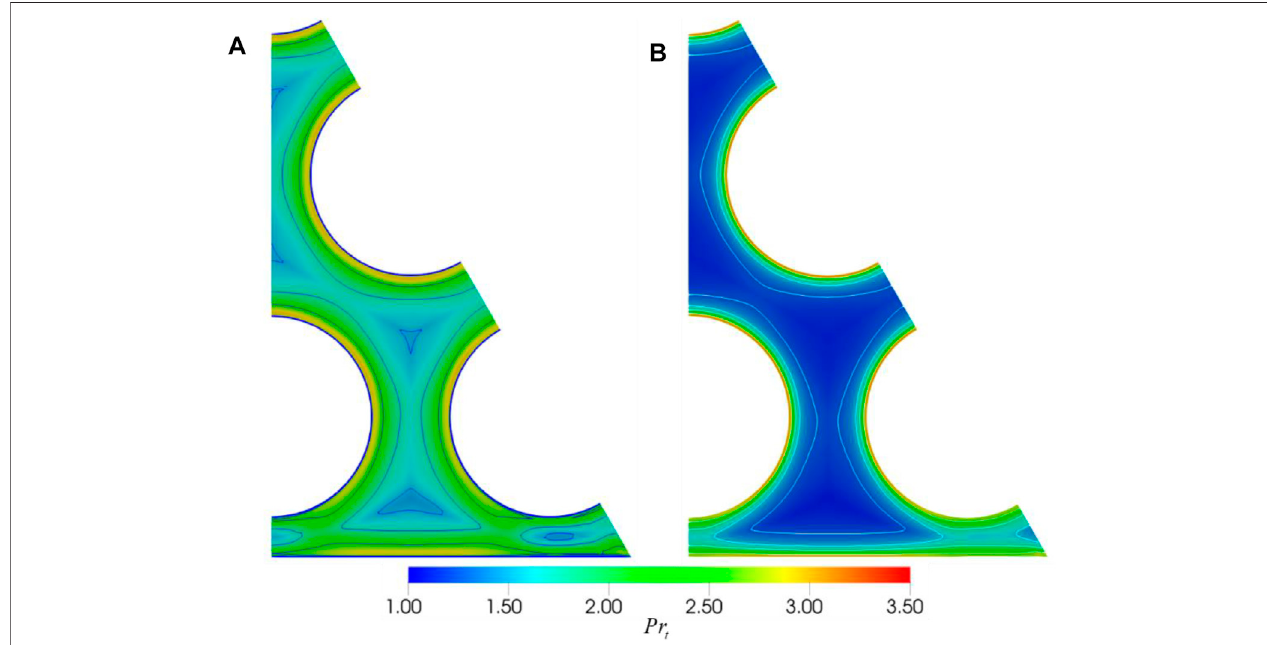
FIGURE 9 | Turbulent Prandtl number distribution on a computational domain. (A) Pe bun (cid:2) 1000 and (B) Pe bun (cid:2) 3000 .